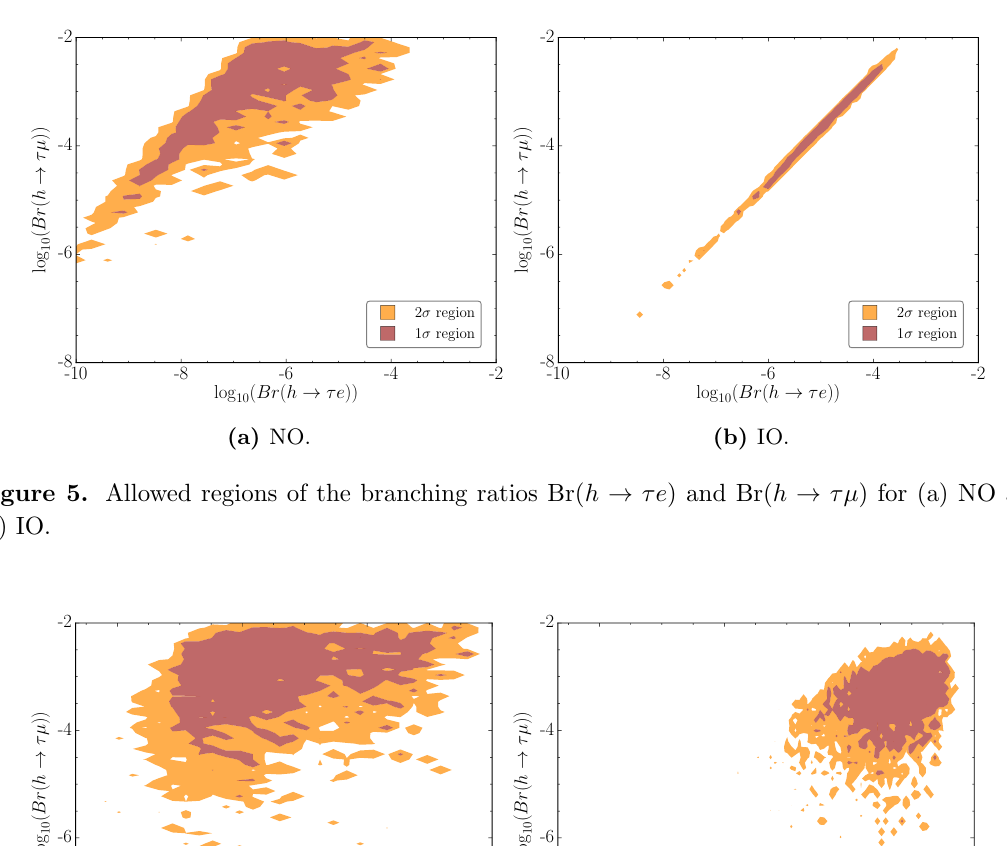
(cid:28)(cid:22) ) for (a) NO and !